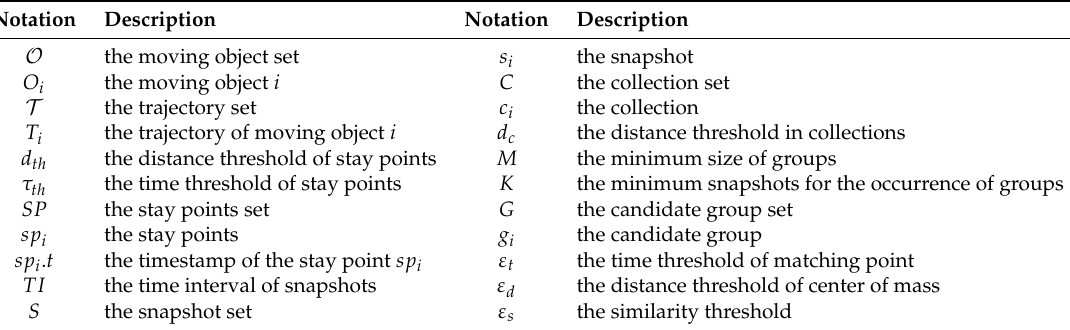
Table 1. Description of the Notations.